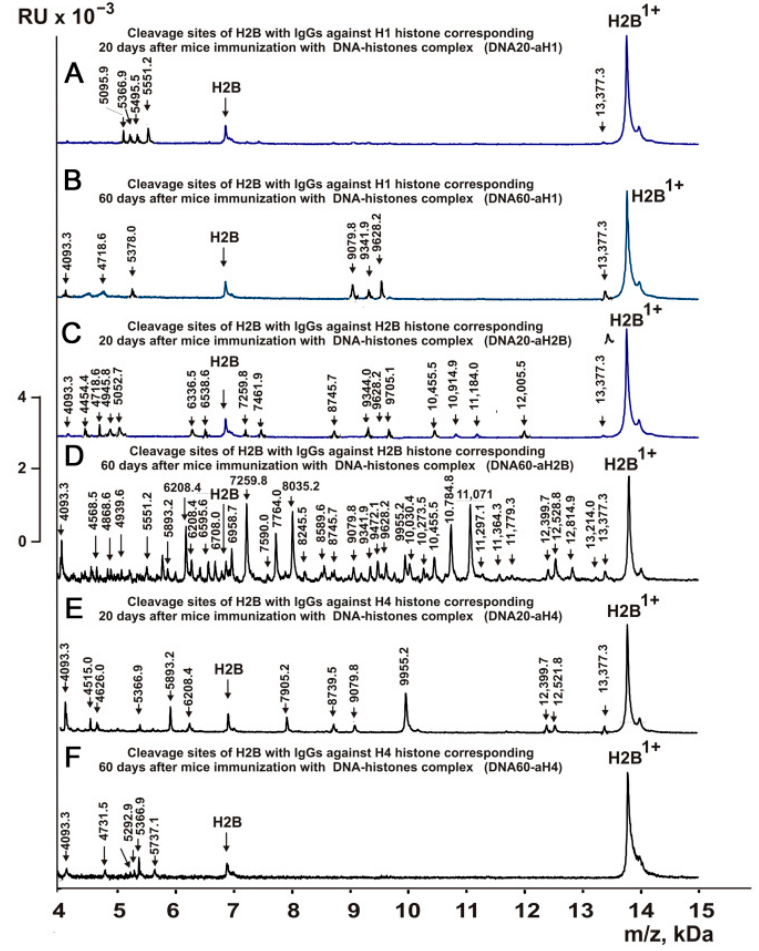
Figure 5. MALDI spectra of H2B (0.9 mg/mL) hydrolysis products with IgGs against three histones corresponding to 20 and 60 days after mouse immunization with DNA-histone complex: DNA20-aH1 ( A ), DNA60-aH1 ( B ), DNA20-aH2A ( C ), DNA60-aH2A ( D ), DNA20-aH2B ( E ), and DNA60-aH2B ( F ). All designations of IgG preparations and values of m/z are shown in the figure.